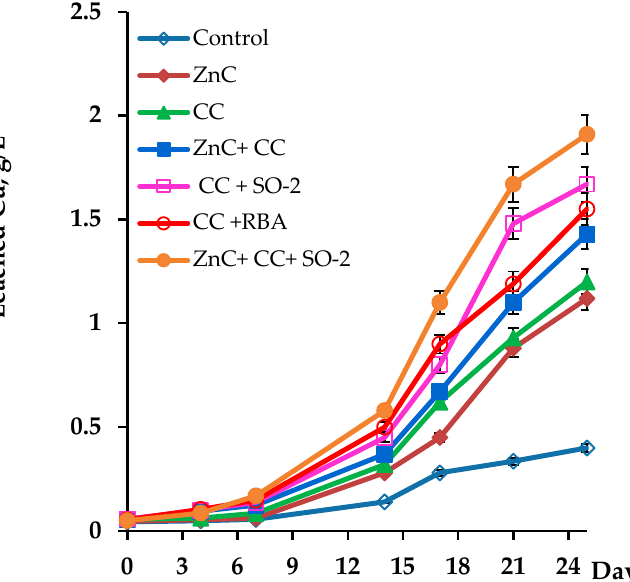
Figure 7. Leaching of copper from chalcopyrite by a pure culture of L. ferriphilum CC and association with other iron- and sulfur-oxidizing bacteria (T 35 °C; pH 1.8; 180 rpm; PD 4%).